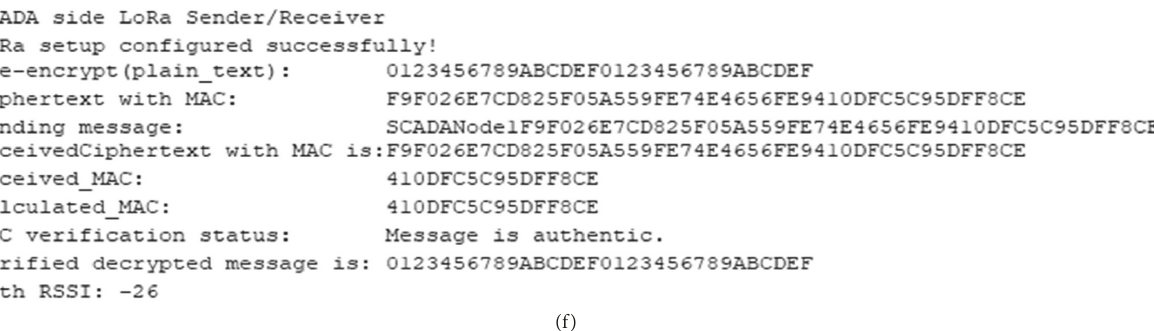
Figure 14: (a) AES implementation on Arduino DRF1276G with LoRa module. (b) AES implementation results on ESP32 with LoRa module. (c) Implementation of AES with MAC on ESP32 with LoRa module. (d) Results of terminal node in a mesh network. (e) In- termediate level node forwarding message back and through in the mesh network. (f) Message sent from SCADA unit with the targeted node